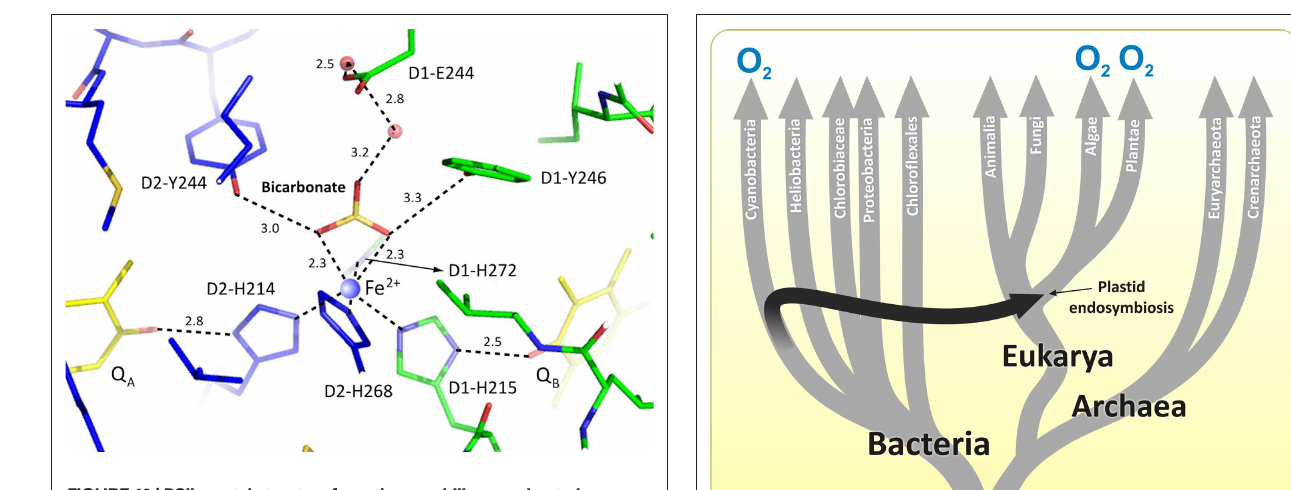
FIgurE 10 | PSII crystal structure from thermophilic cyanobacterium Thermosynechococcus vulcanus (Courtesy of Jian-ren Shen, personal communication, 2011 to the authors; see umena et al., 2011). This figure shows the location of HC (bicarbonate) that is bound to non-heme iron (Fe 2 + ; see blue circle in the center). Amino acids within 3.3 Å of HC are two tyrosines and one histidine: D1-Y246; D2-Y244; D1-H272. D2-K264 is not shown. (The concept has evolved in Govindjee’s laboratory, beginning with the work of Alan Stemler, followed by extensive work of Thomas J. Wydrzynski, Paul Jursinic, Rita Khanna, Danny Blubaugh, Julian Eaton-Rye, Sarojini Bose, Fatima El-Shintinawy, Jack J.S. Van Rensen, Wim F.J. Vermaas, Chunhe Xu, Jinchiang Cao, and Jin Xiong (the latter two worked on cyanobacteria) that HC plays a key FIgurE 11 | The origin and evolutionary tree of life that is based on role on the electron-acceptor side of PSII.) These researchers among many small-subunit rNA. The branches that perform oxygenic photosynthesis others, have suggested that there is a unique role of HC in the electron flow are labeled with 'O '. The black arrow indicates the plastid endosymbiotic − , and proton transport to Q − (Van Rensen et al., 1999). from reduced Q to Q 2 B B A event that resulted in the origin of eukaryotic photosynthesis from The model shown here provides detailed information that will allow future cyanobacteria-like organisms, which ultimately became chloroplasts in algae experimenters to find the molecular mechanism of the HC effect on the PSII. and later in plants. However, while chloroplasts of the higher plants, glaucophytes, green and red algae are thought to be the result of the plastid (primary) endosymbiosis, all other groups of algae are assumed to have arisen due to the algal (secondary and tertiary) endosymbiosis (not shown), in which one eukaryotic alga was incorporated into another eukaryote. For details, see Olson and Blankenship (2004), Blankenship et al. (2007), Hohmann-Marriott and Blankenship (2011), Kim et al. (2011), Garcia-Mendoza et al. (2011). Only some branches of bacteria, eukarya, and archaea are displayed. Modified and adapted from Blankenship (2002) and Blankenship et